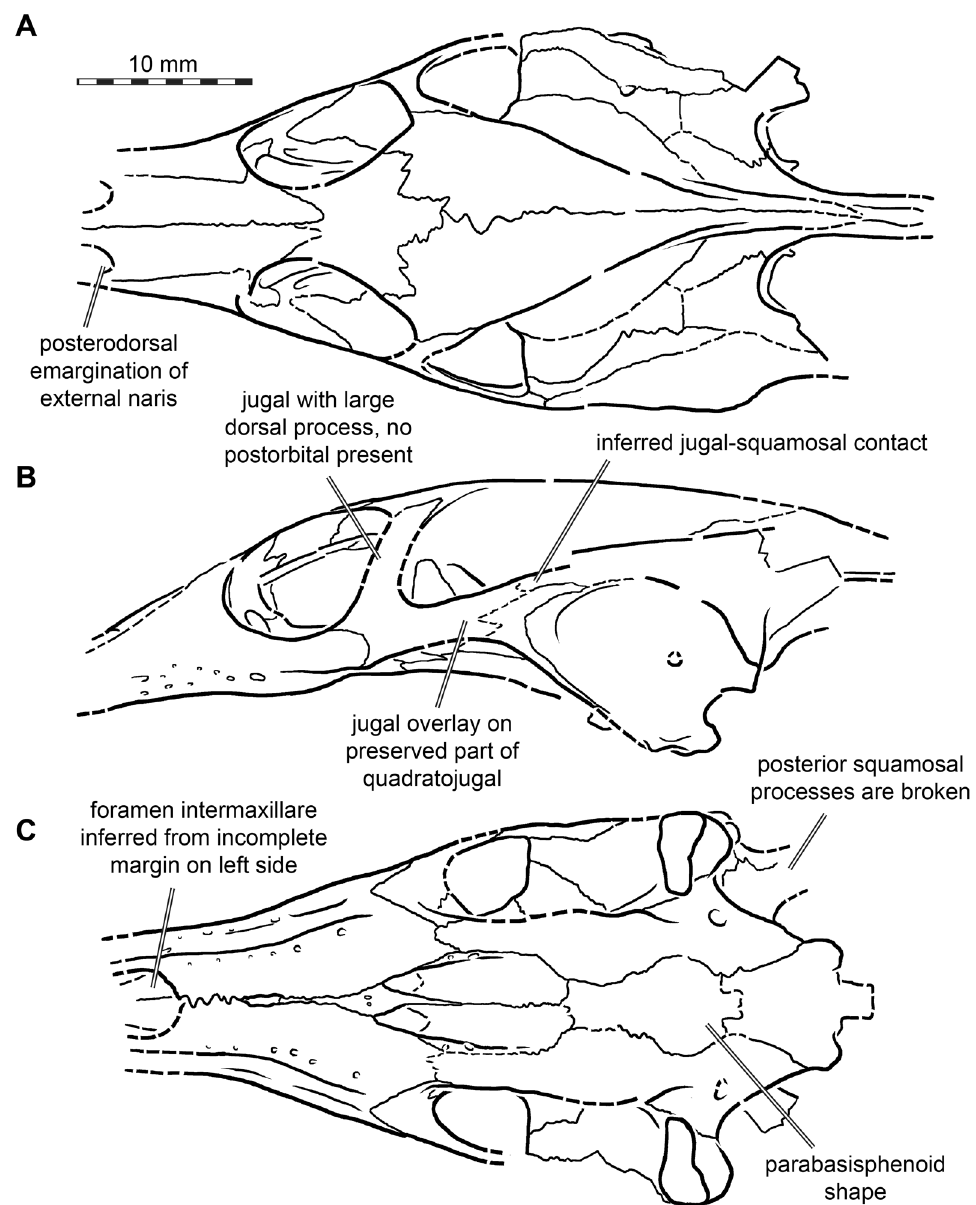
Fig. 4 Interpretative line drawings of the cranium of Plastomenus thomasii (AMNH FR 6015). A dorsal view. B left lateral view. C ventral